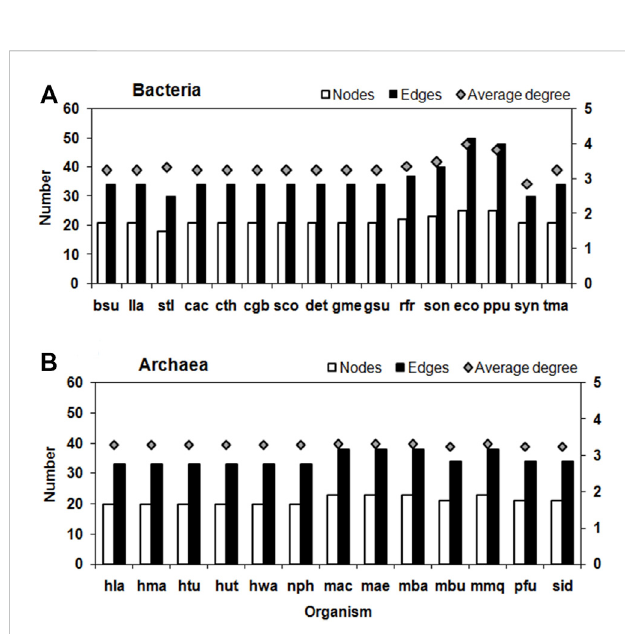
FIGURE 3 Number of Nodes, Edges (left Y -axis) and average degree (right Y -axis) of TTP pathway network in (A) Bacteria and (B) Archaea. See Supplementary Table S1 for the three lettered species